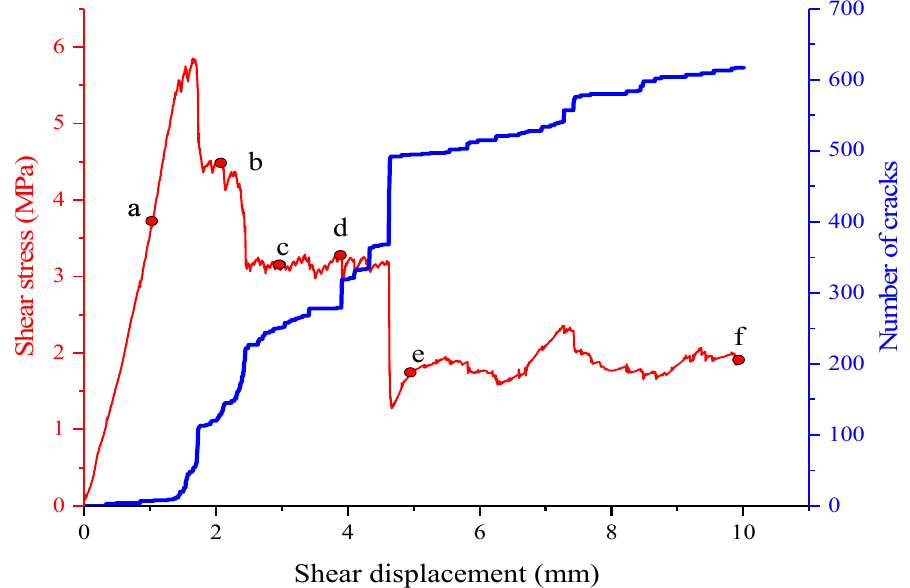
Figure 6. The shear stress and number of cracks in the serrated structural plane. (a, b, c, d, e, and f correspond to the monitoring points where the shear displacements are 1 mm, 2 mm, 3 mm, 4 mm, 5 mm and 10 mm, respectivel y ).